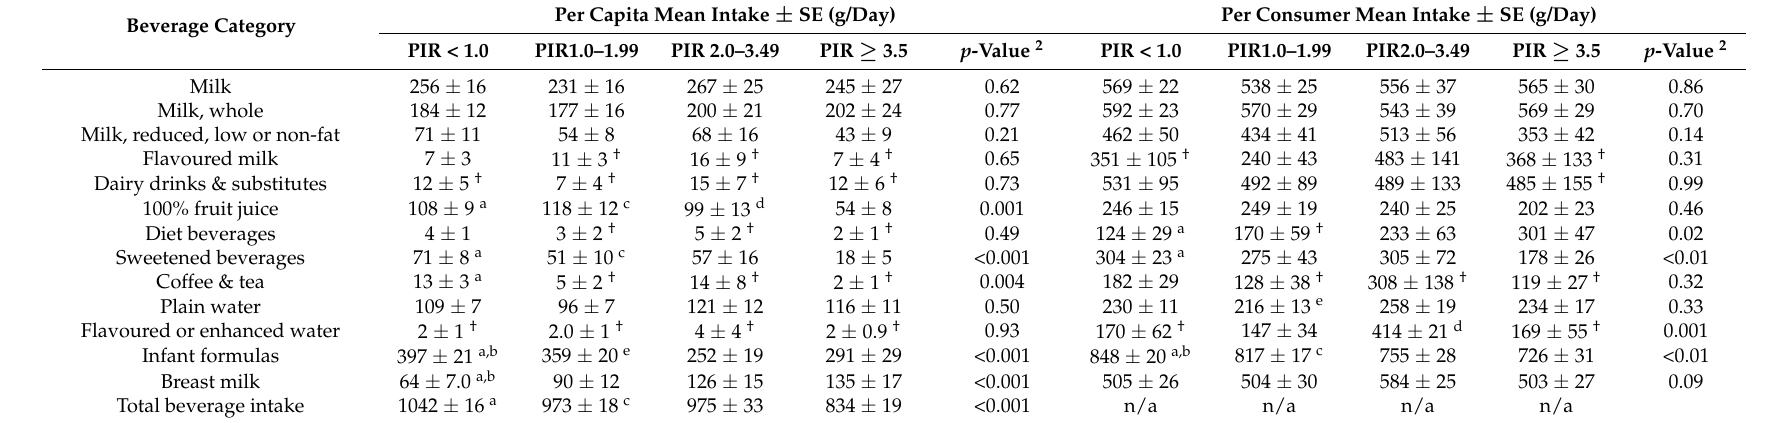
Table 4. Beverage consumption by poverty–income ratio ( n = 2554) 1,2